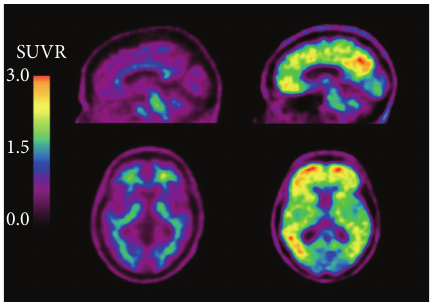
Figure 4: Sagittal and axial PET images using [ 18 F]florbetaben. Both patients are female, are of the same age, and have the same MMSE score. The difference is that the patient on the left has mild cognitive impairment and demonstrates little retention of [ 18 F]florbetaben, while the patient on the right has Alzheimer’s disease and demonstrates high cortical [ 18 F]florbetaben retention. This retention is represented in the standard pattern seen in AD: highest levels are retained in the posterior cingulate region as well as the frontal and temporal cortices ([59], reprinted with